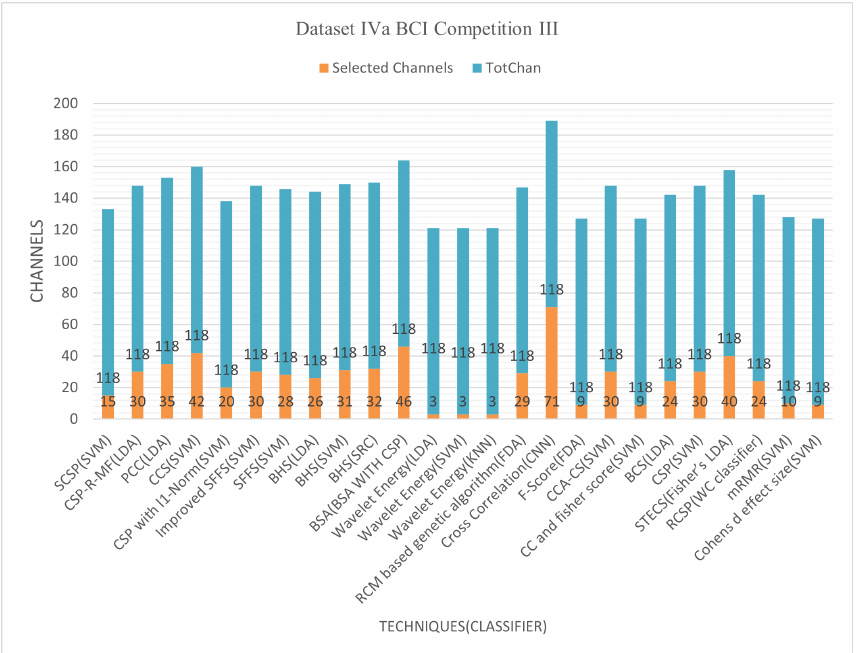
Figure 6. Selected channels by different techniques for Dataset IVa BCI Competition